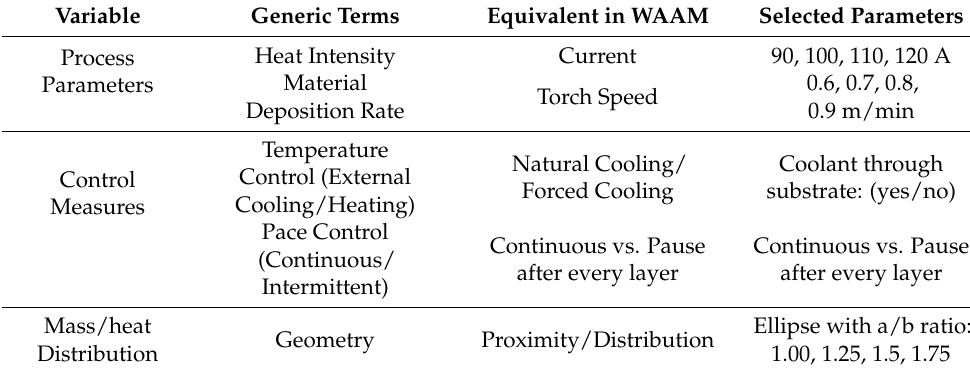
Table 3. Parameters considered for experimentation.